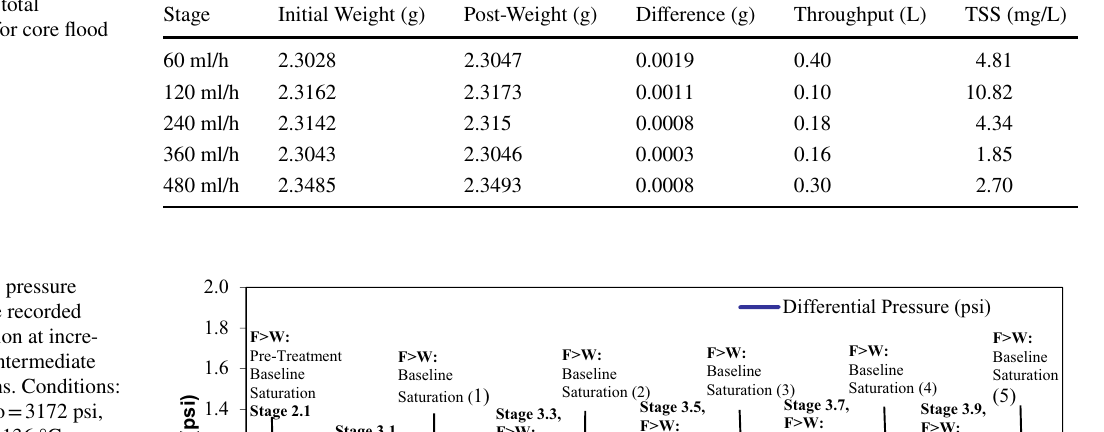
Table 10 Effluent total suspended solids for core flood 3